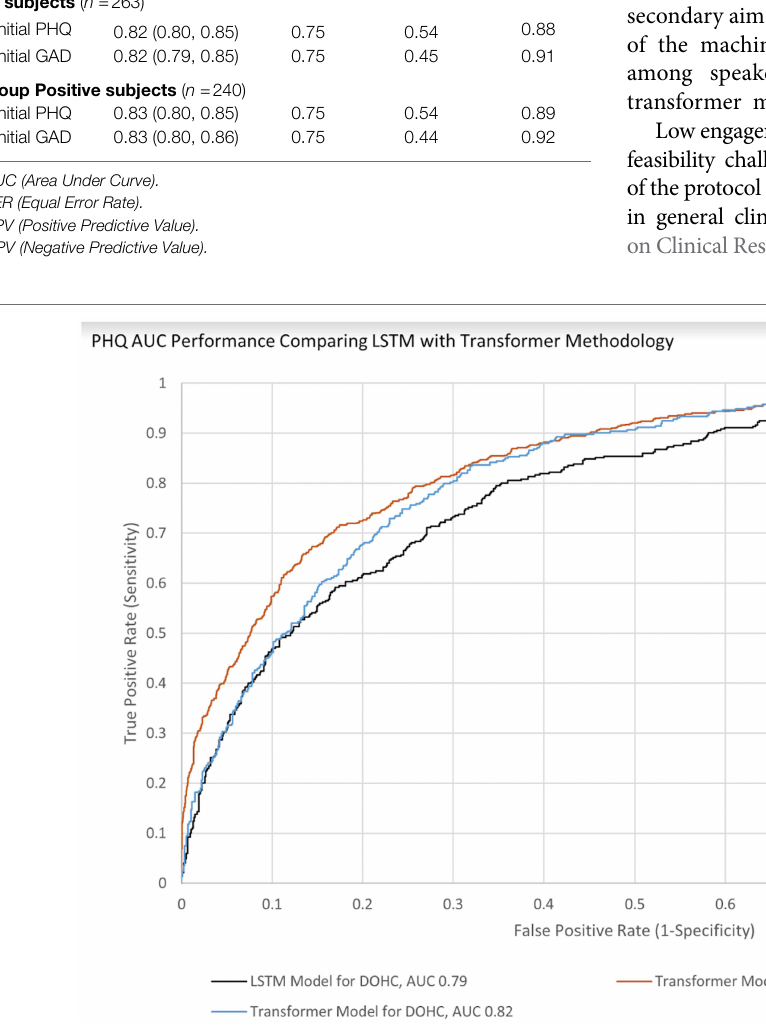
FIGURE 4 | PHQ AUC Performance Comparing LSTM with Transformer Methodology for Both GP and